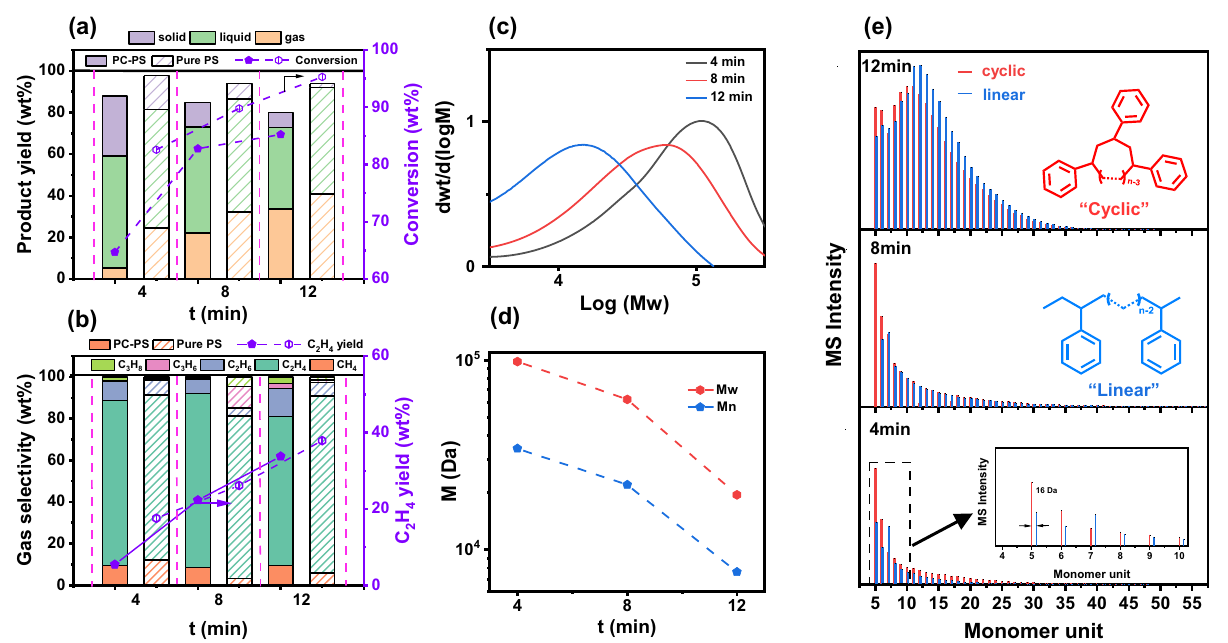
Fig. 5 Plasma-assisted post-consumer PS (PCPS) hydrogenolysis properties as a function of reaction time. a Product yield and conversion properties. b Gas products selectivity and ethylene yield properties. c , d GPC spectra and molecular weight evolution as a function of reaction time. e MALDI-MS spectra of liquid components obtained from PCPS-4min, PCPS-8min and PCPS-12min, respectively. Cyclic and linear polystyrenes were represented in red and blue,